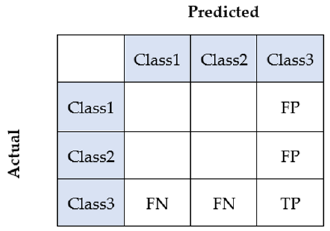
Figure 8. Distribution of TP, FP, and FN in multiclassification problems.